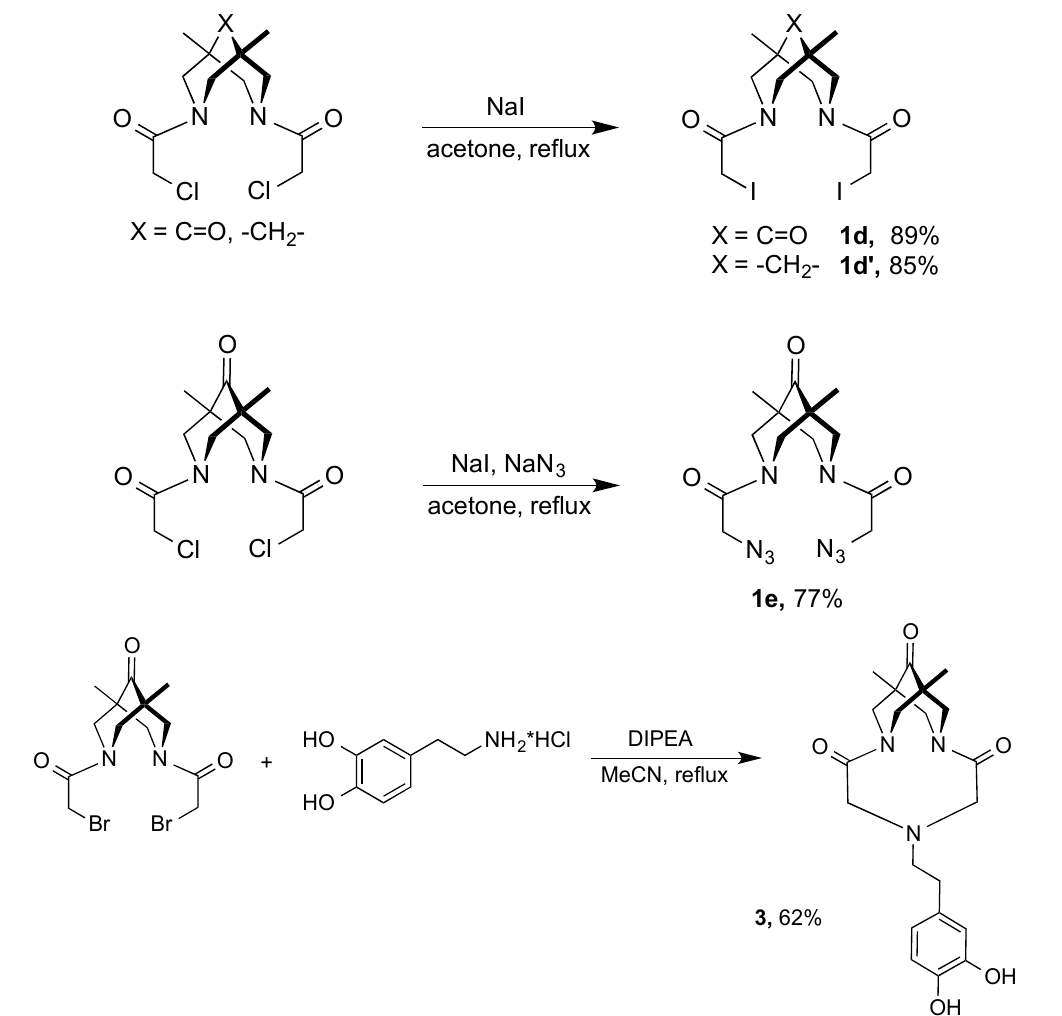
Scheme 5. Synthesis of compounds 1d , 1d (cid:48) , 1e , and 3 by nucleophilic substitution